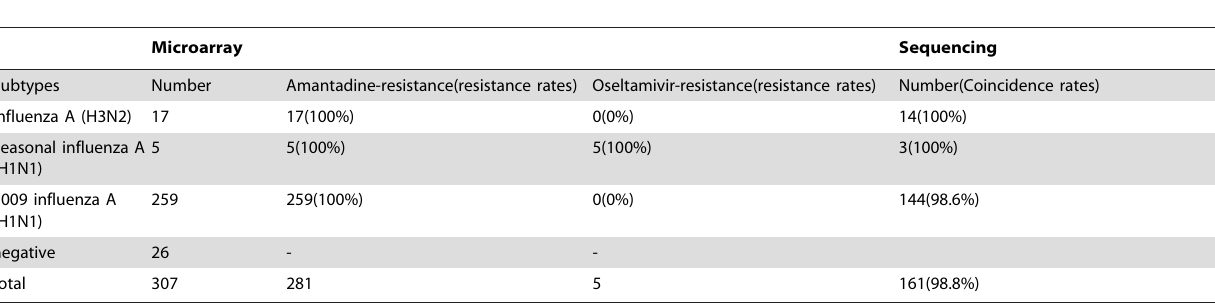
Table 4. The subtypes and resistant genotypes results of clinical throat swab